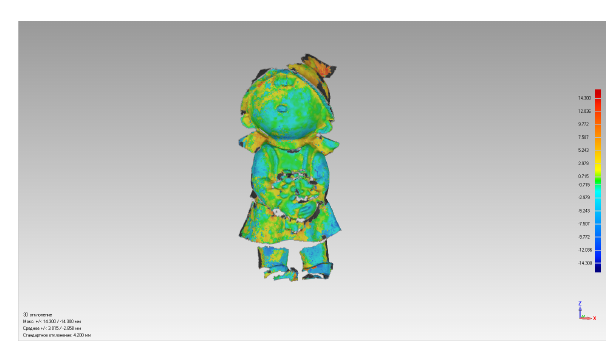
Figure 8. Evaluation result for the Gnome statue for images from MSVIR dataset.